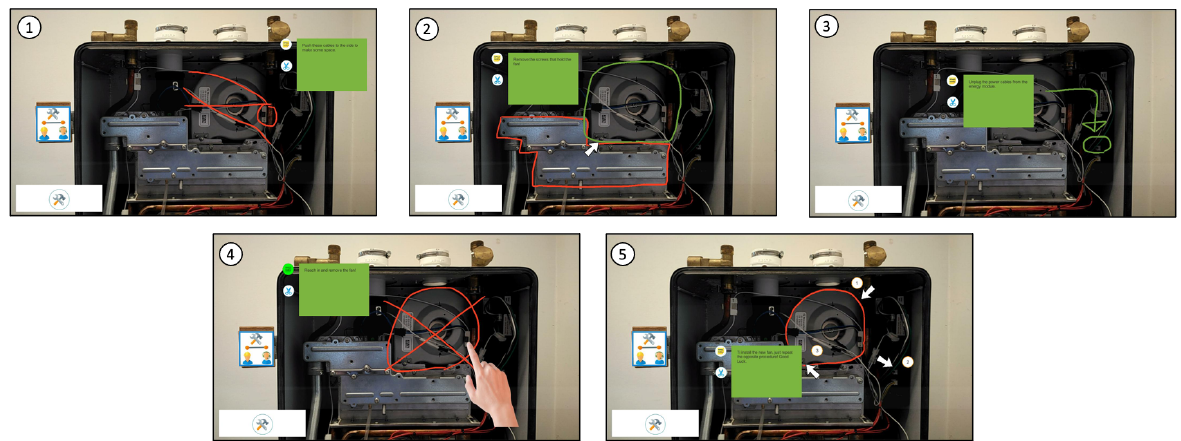
Figure 4. Step-by-step instructions analysed: 1—push the cables to the side to make some space; 2— remove the screws that hold the fan; 3—unplug the power cables from the energy module; 4—reach in and remove the fan; 5—install the new fan by just repeating the opposite